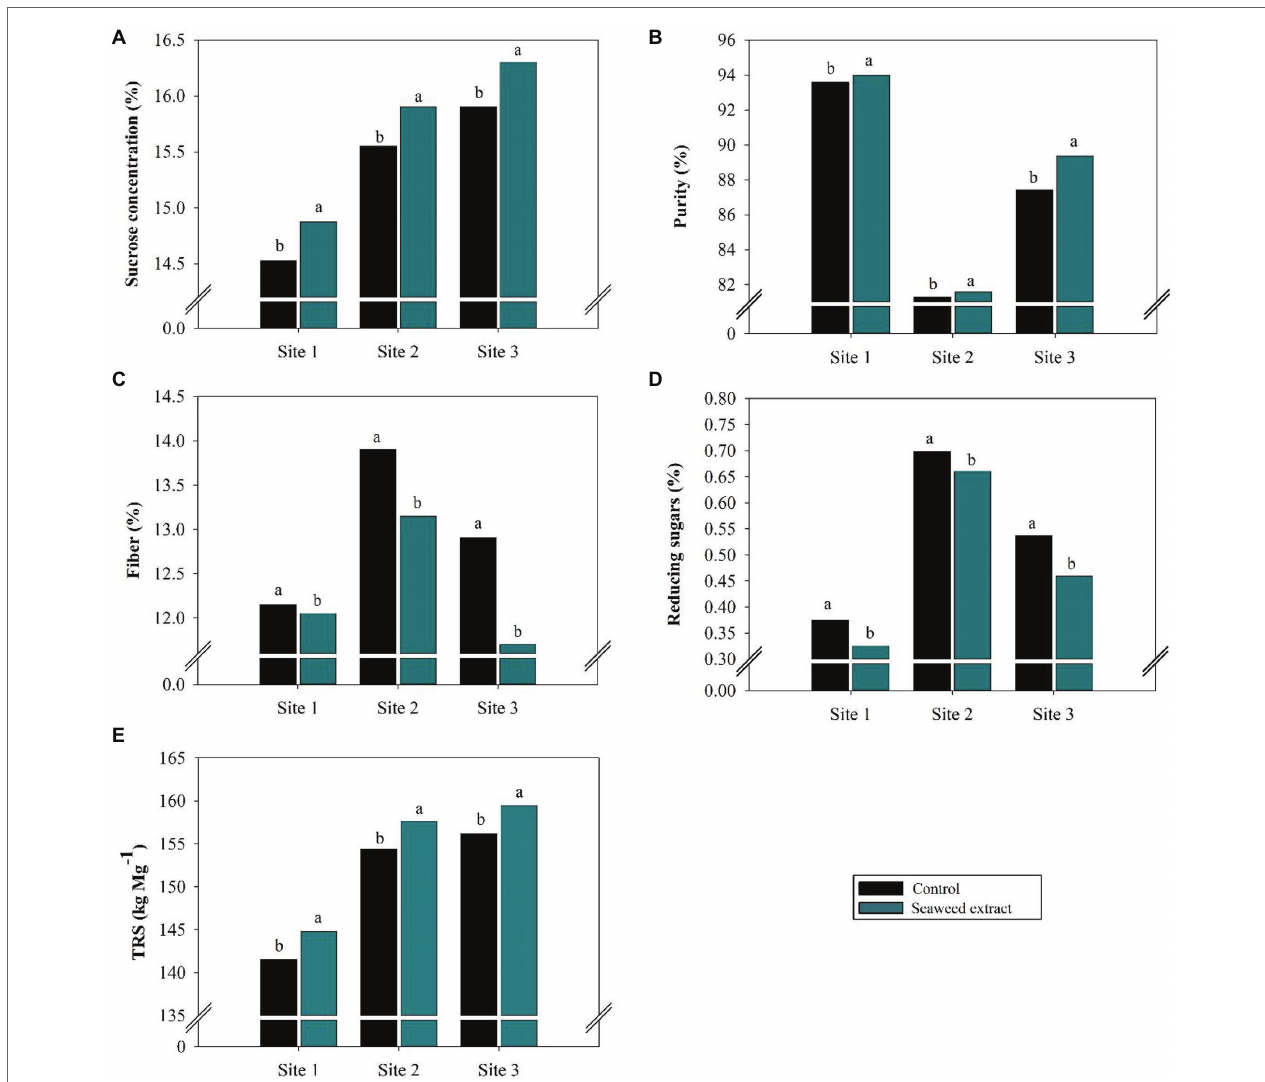
FIGURE 6 | Effects of seaweed extract (SWE) application on sugarcane technological parameters at harvest: (A) sucrose concentration (%), (B) purity (%), (C) fiber (%), (D) reducing sugars (%), and (E) total reducing sugars (kg Mg − 1 ). The treatments were as follows: Control, no SWE application; Seaweed extract: application of SWE biostimulant based on Ascophyllum nodosum in the beginning of the drought season (July at site 1 and June at sites 2 and 3). Averages followed by the same letters do not differ by the LSD test ( p <